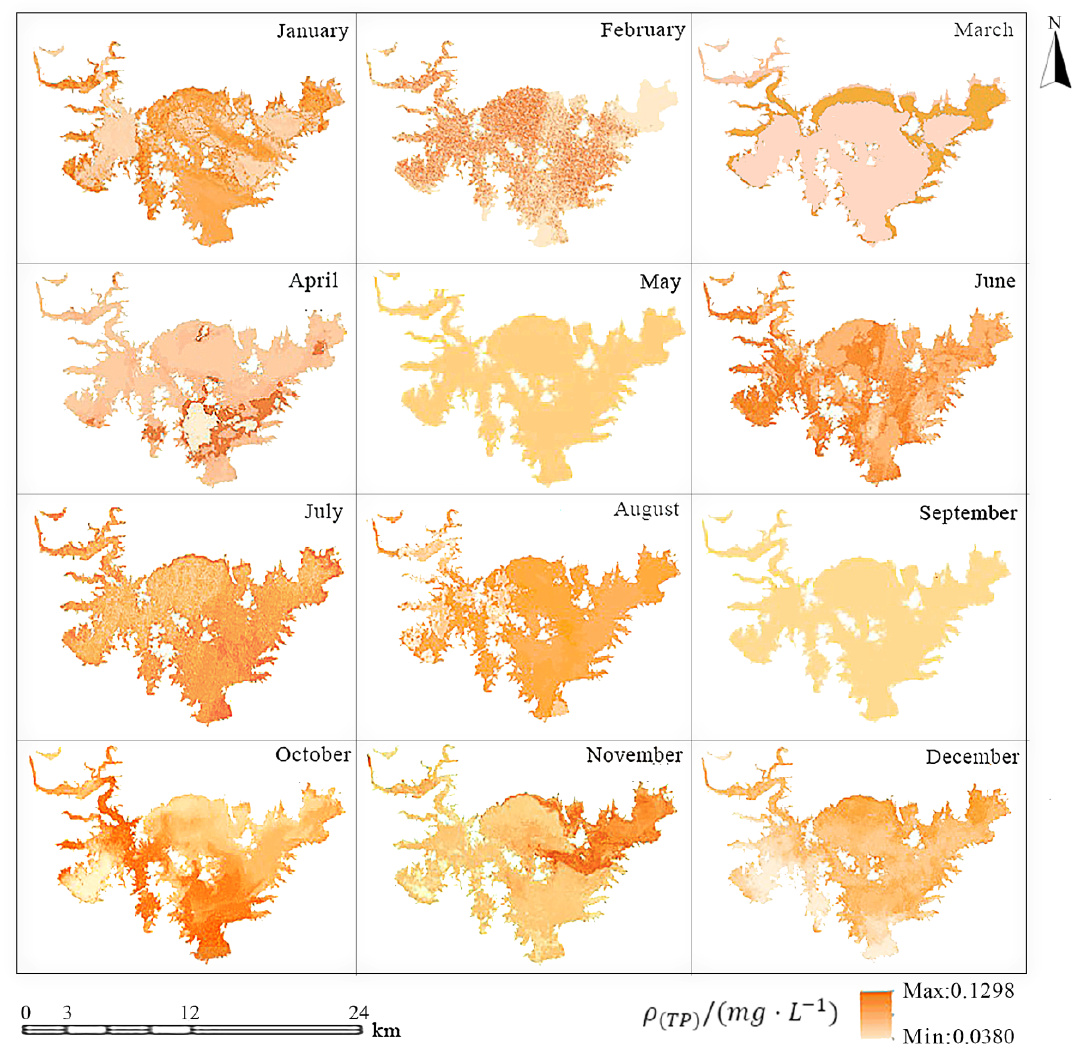
Figure 8. Spatio-temporal distribution of the TP concentration in Miyun Reservoir.